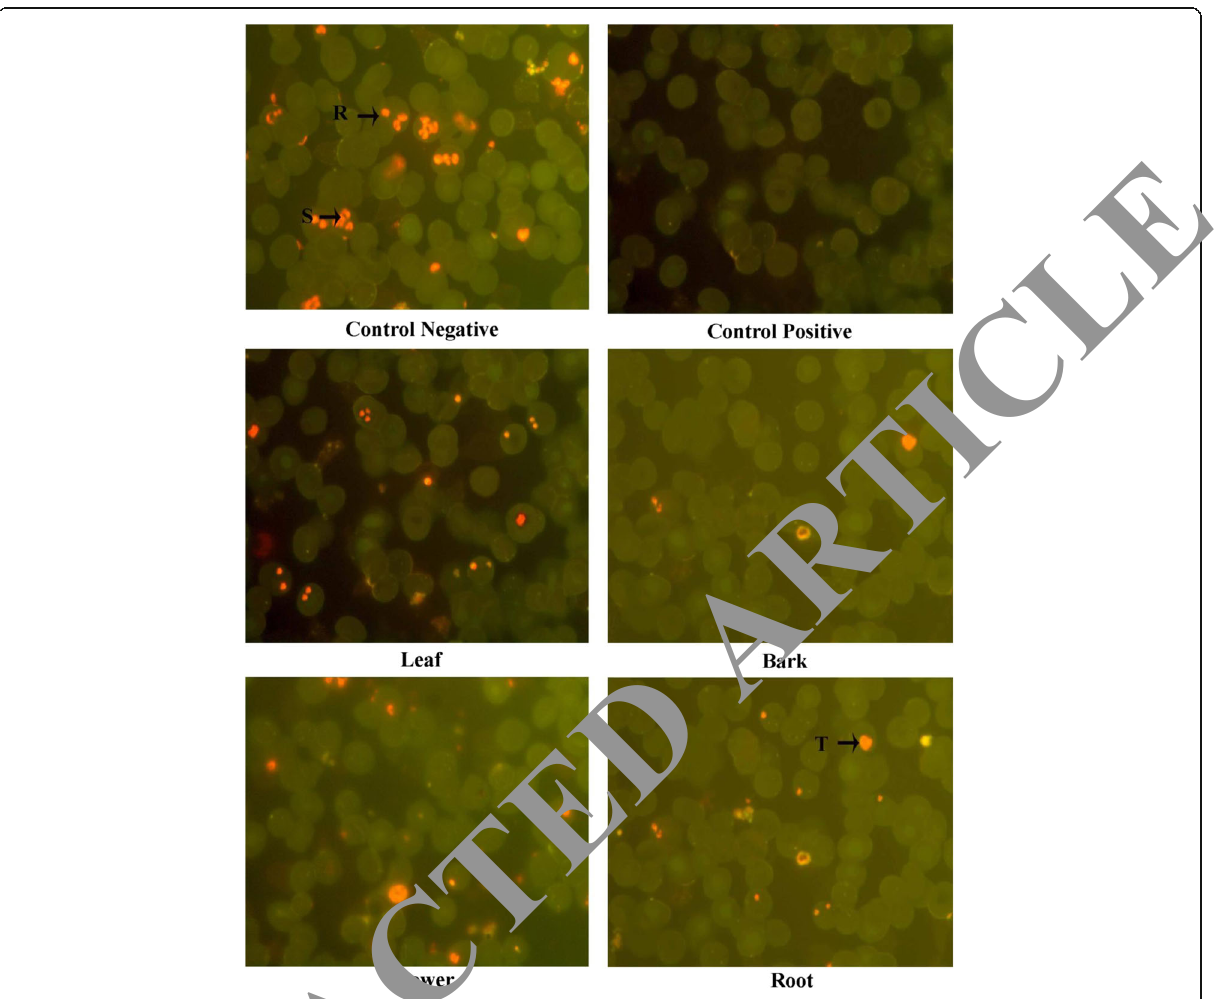
Fig. 2 Microscopic observations after treatment with methanolic extracts of Pongamia pinnata against P. falciparum 3D7 strain at the highest concentration (200 μ g/mL) with Acridine Orange stain at 1000× magnification (R- ring stage, T- trophozoite, S-